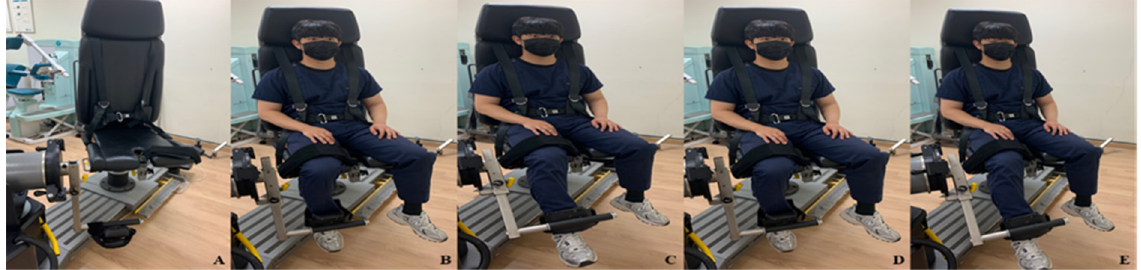
Figure 4. CSMI. ( A ) CSMI; ( B ) starting position; ( C ) set leg to target angle; ( D ) back to ( B ) and close eyes; ( E ) make a target angle.